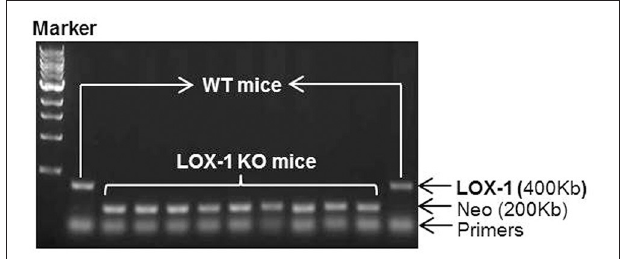
FIGURE 1 | Genotyping results of LOX-1 KO mice and WT mice used in this study. Neo represents the inserted neomycin resistance gene.